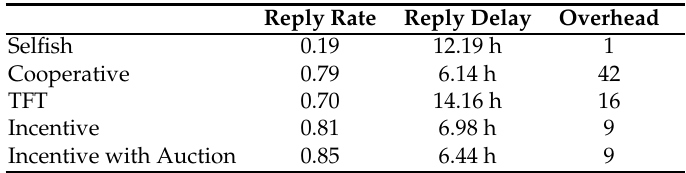
Table 3. Overall performance comparison based on the